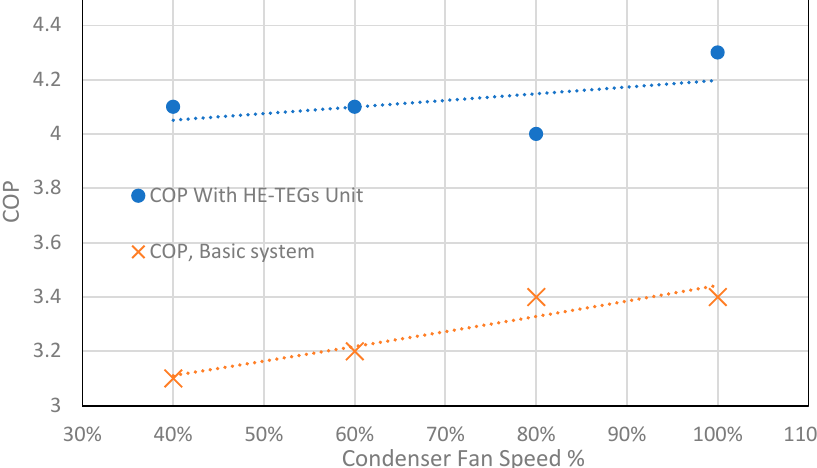
Figure 10. Variation of COP of refrigeration system with condenser fan speed with and without HE-TEGs unit.